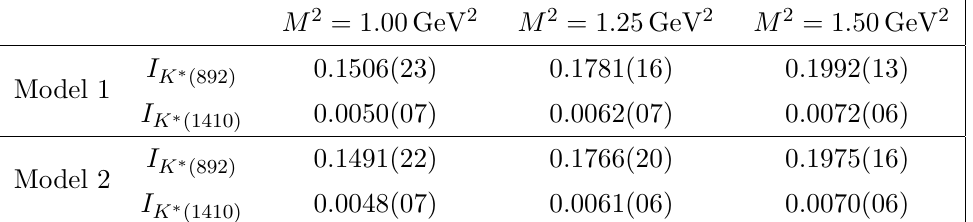
=I ’ 0 : 03 in all K (cid:3) (1410) K (cid:3) (892)